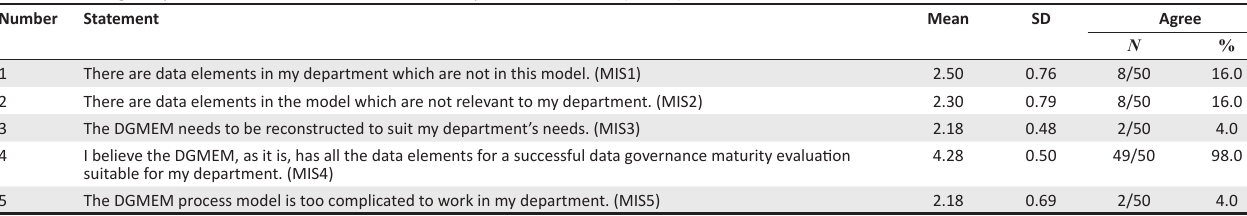
TABLE 7: Missing components of the Data Governance Maturity Evaluation Model ( N =